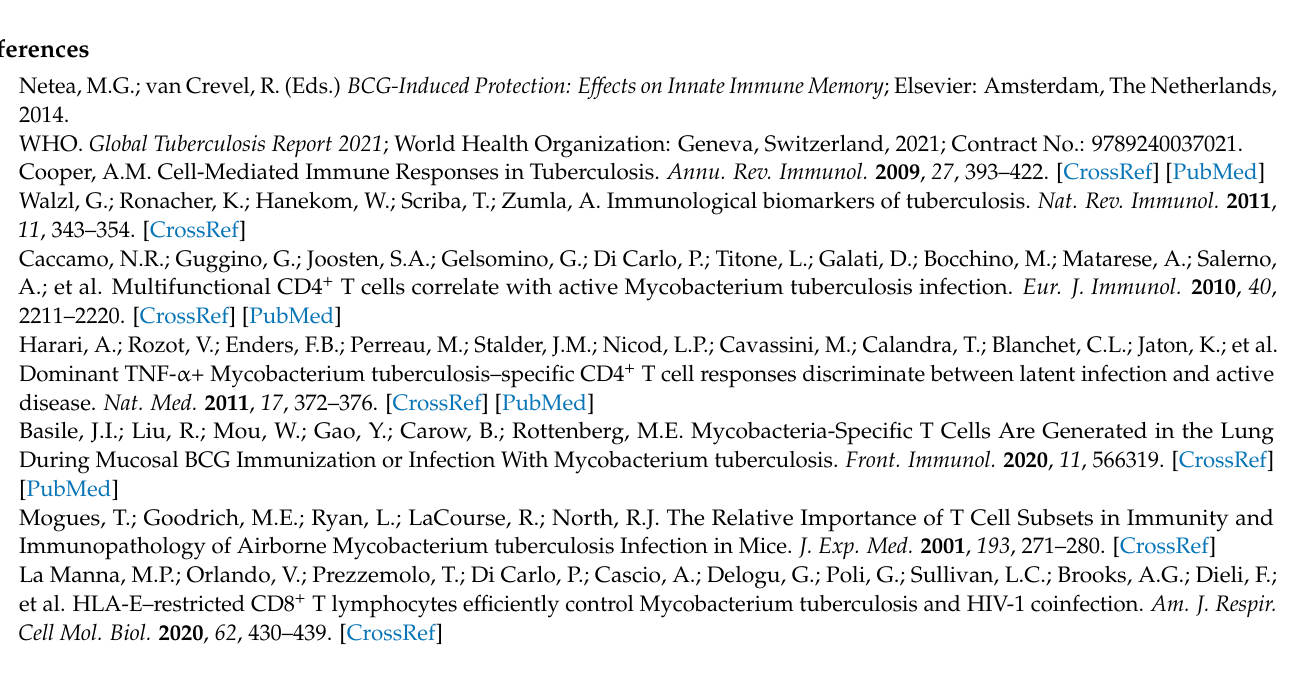
lymphocyte subsets; Figure S2: Clustering and cell subset identification: quality control; Table S1: List of genes in database (accession number: